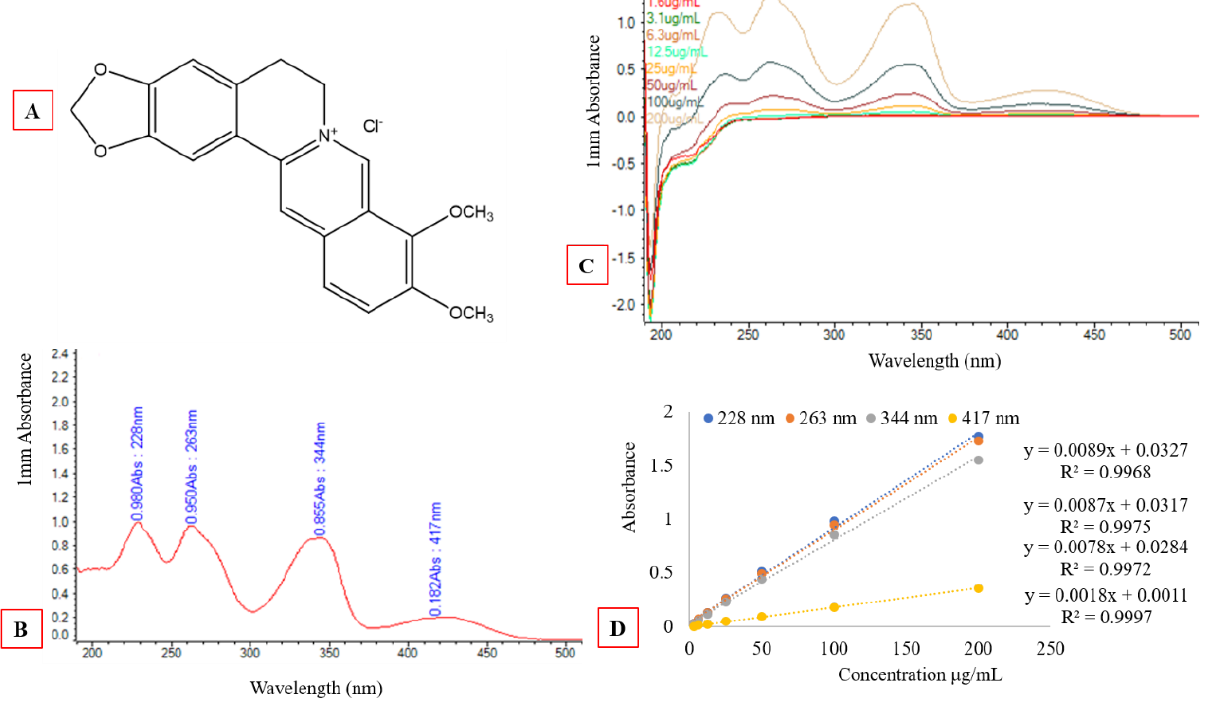
Figure 1: Light absorption characteristics of BBR. (A). Structural formula of BBR. (B). Absorption spectrum of BBR, showing 4 absorption peaks at 228, 263, 344 and 417 nm. The concentration of BBR was 100 μg/mL. (C). Absorption peaks consistent with BBR at different concentrations. (D). Absorbance- concentration curves of BBR. For (C) and (D), the concentrations of BBR were 1.6, 3.1, 6.3, 12.5, 25, 50, 100 and 200